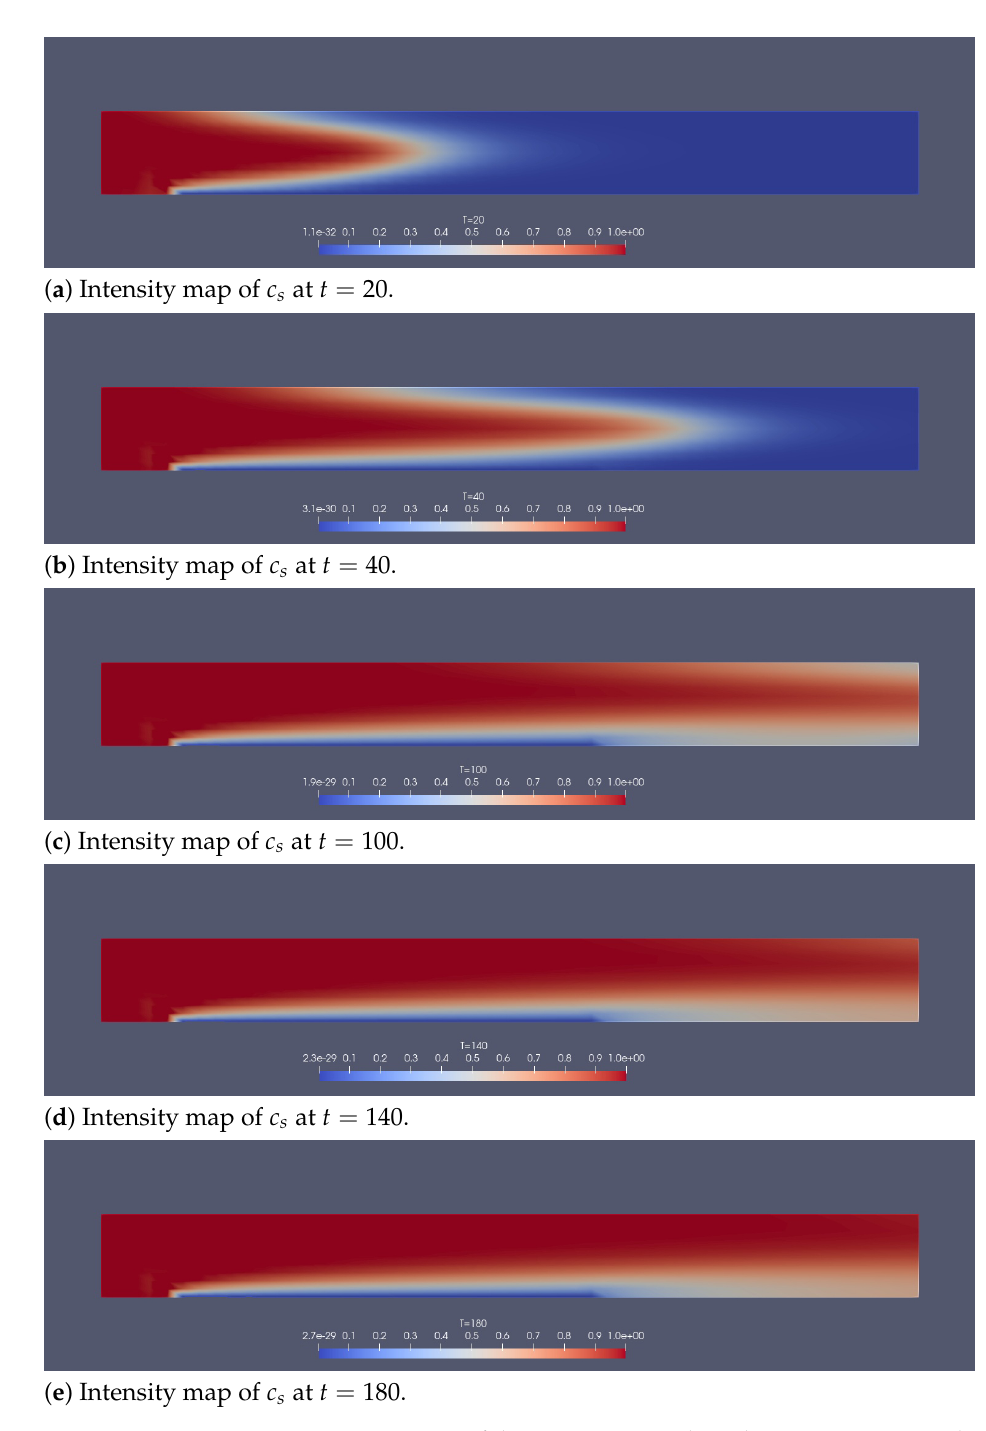
Figure 14. For Section 5.2: intensity maps of the concentration electrolyte ions c s computed with δ t = 1 and a 100 × 10 uniform mesh. The blue zone in the plating region on the lower plate shows that the electrolyte is absorbed by the plating